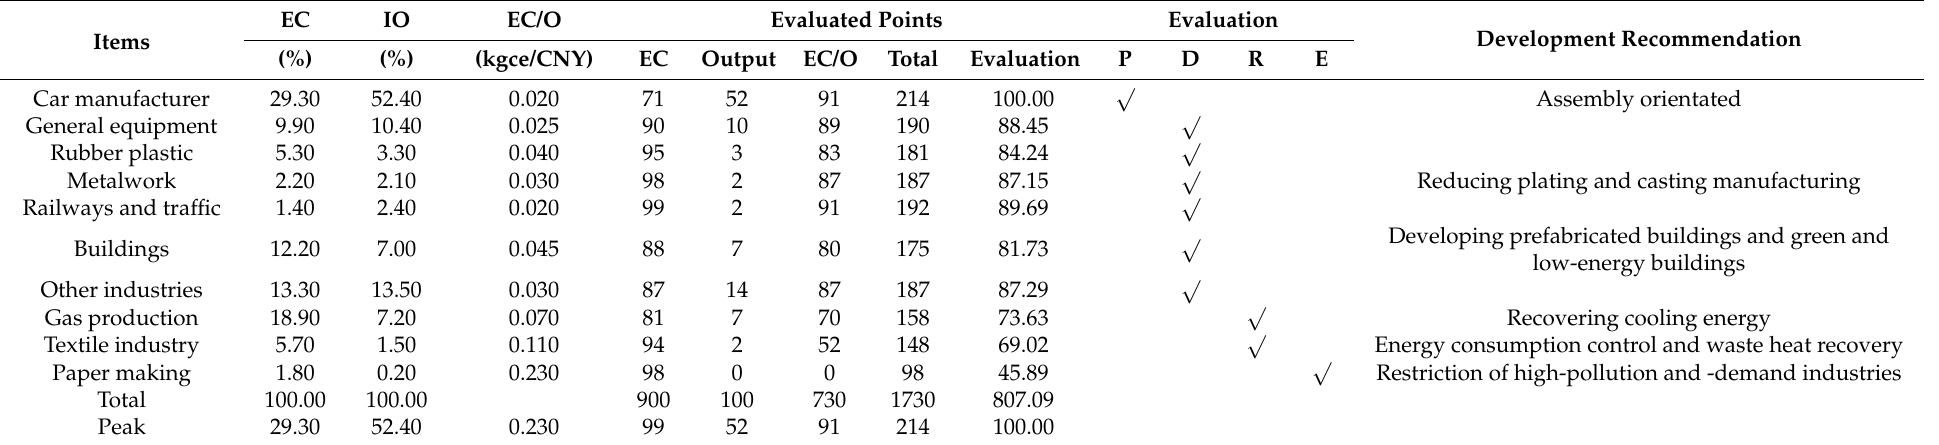
Table 9. The evaluation and development recommendations of industrial